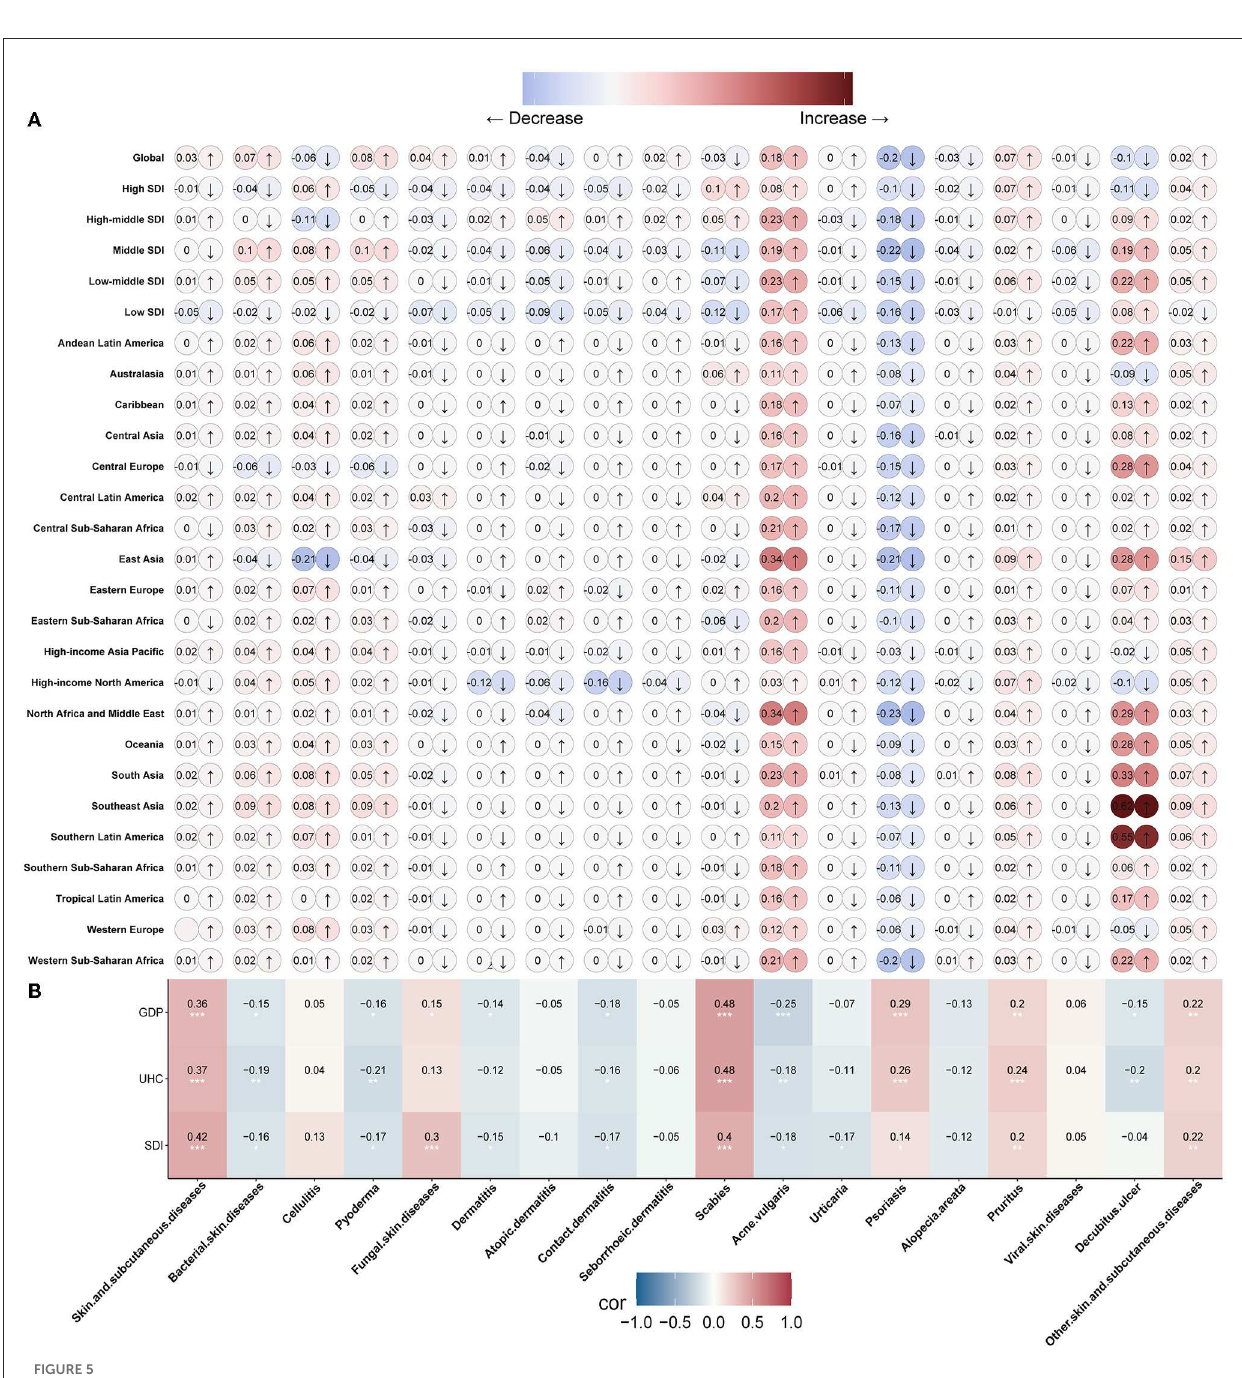
increased globally, which highlights the remarkable achievements in preventing these diseases. Skin and subcutaneous diseases are common in patients with lower SDI scores, and most of their incidences are negatively correlated with SDI, GDP, and UHC. However, psoriasis, pruritus, and scabies are becoming increasingly prominent in high socioeconomic states. This may